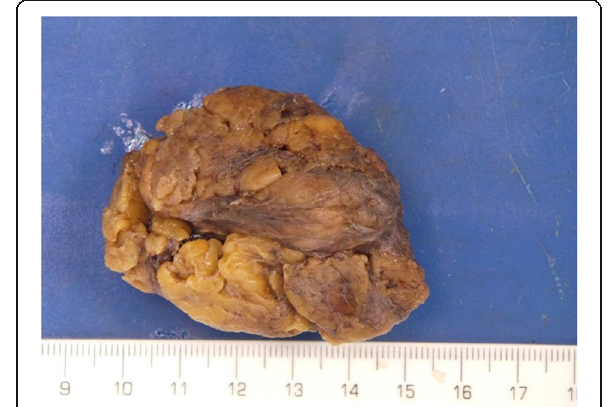
Fig. 2 Macroscopic specimen of primary mediastinal seminoma intact and in cross